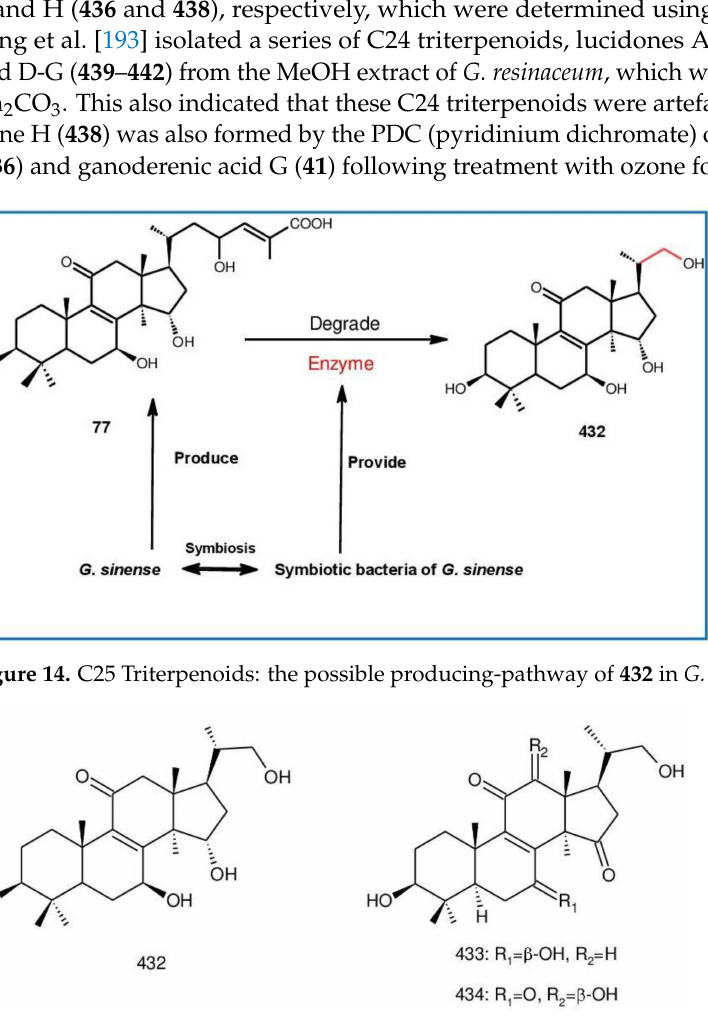
Figure 15. Chemical structures of several C25 triterpenoids ( 432 – 434 ).